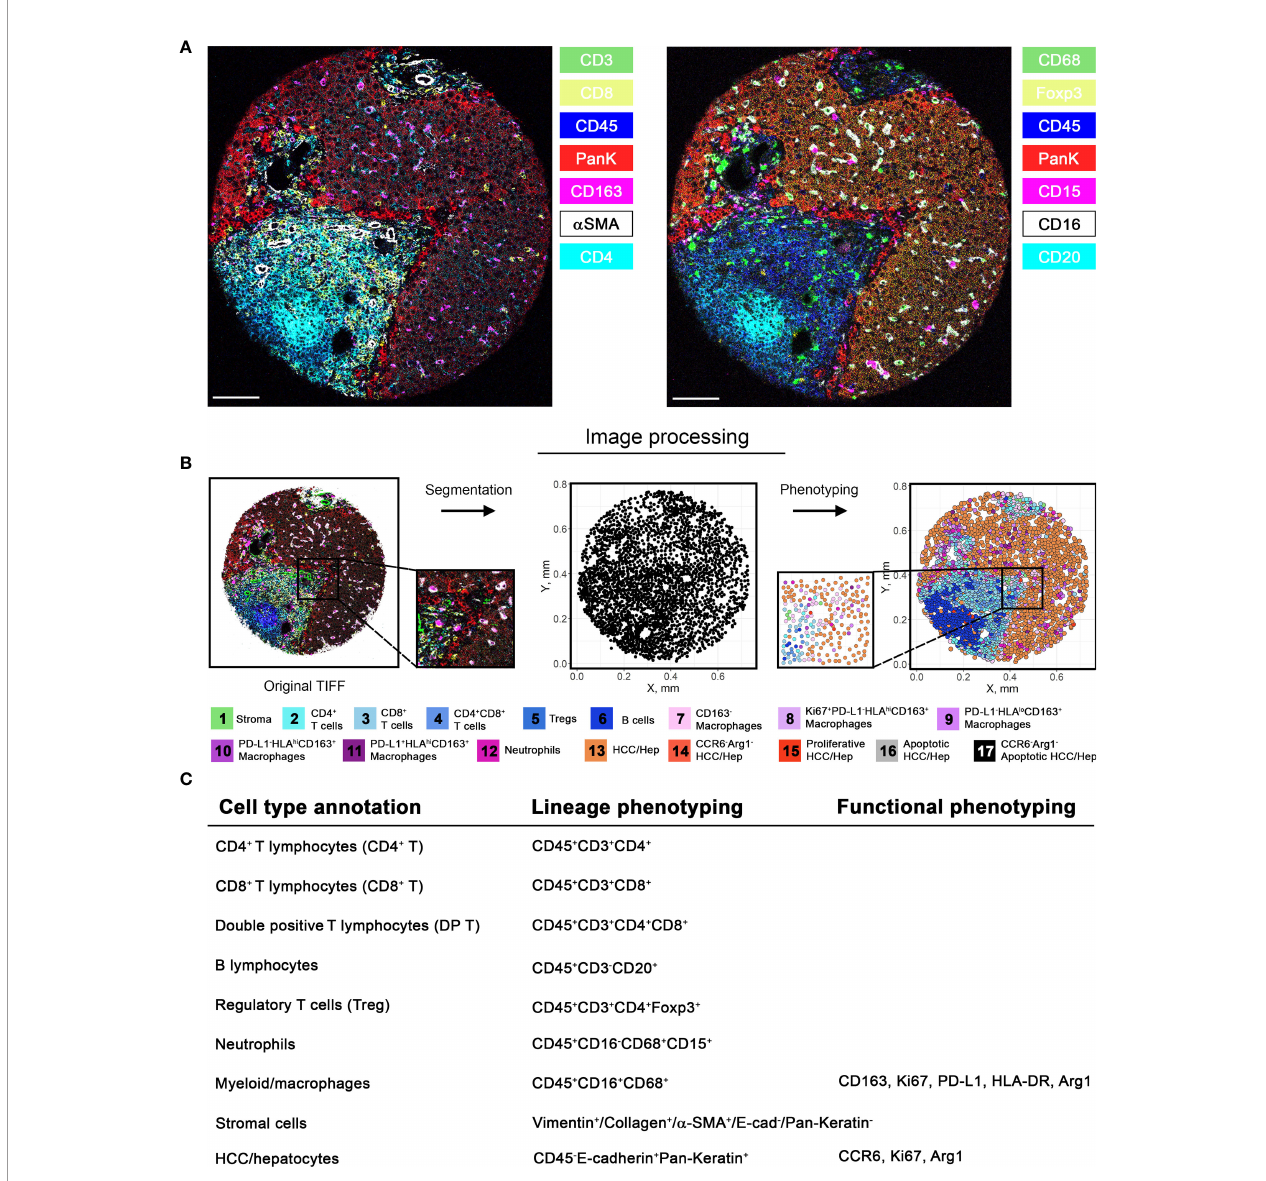
FIGURE 2 | Image processing pipeline and cell phenotyping. (A) Among 27-marker panel stained in this study, 14 markers were selected and visualized separately as 7-channel multiplexed images capturing different subsets of cells. (B) Image processing pipeline was initiated by image segmentation based on nucleus and plasma membrane markers. Segmentation allows extraction of marker intensities for each cell, which enables clustering of marker combinations. Clusters were then annotated into fi nal cell phenotypes (unannotatable/non-cell cluster is not included). Markers used to further subtype the clusters are described in (C) . Note that the fi nal annotations are composed of both lineage and additional phenotyping